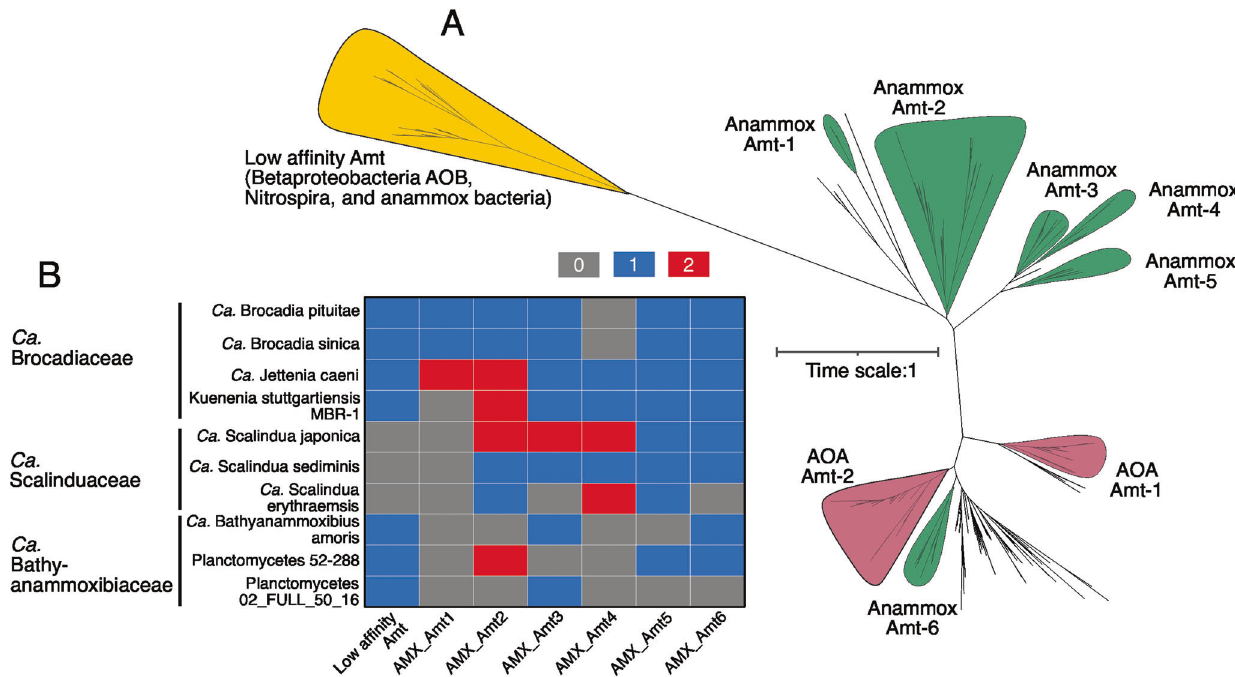
Fig. 6 Phylogeny and distribution of ammonium transporters (Amt) in anammox bacteria. A Maximum-likelihood phylogenetic tree of Amt in anammox bacteria and other related nitrogen cycling groups (AOB, NOB, and AOA). Amt clades of nitrogen cycling groups are highlighted with different colors. The bar indicates estimated sequence divergence per residue. B Heatmap showing the occurrence of Amt in 10 selected high-quality anammox bacterial